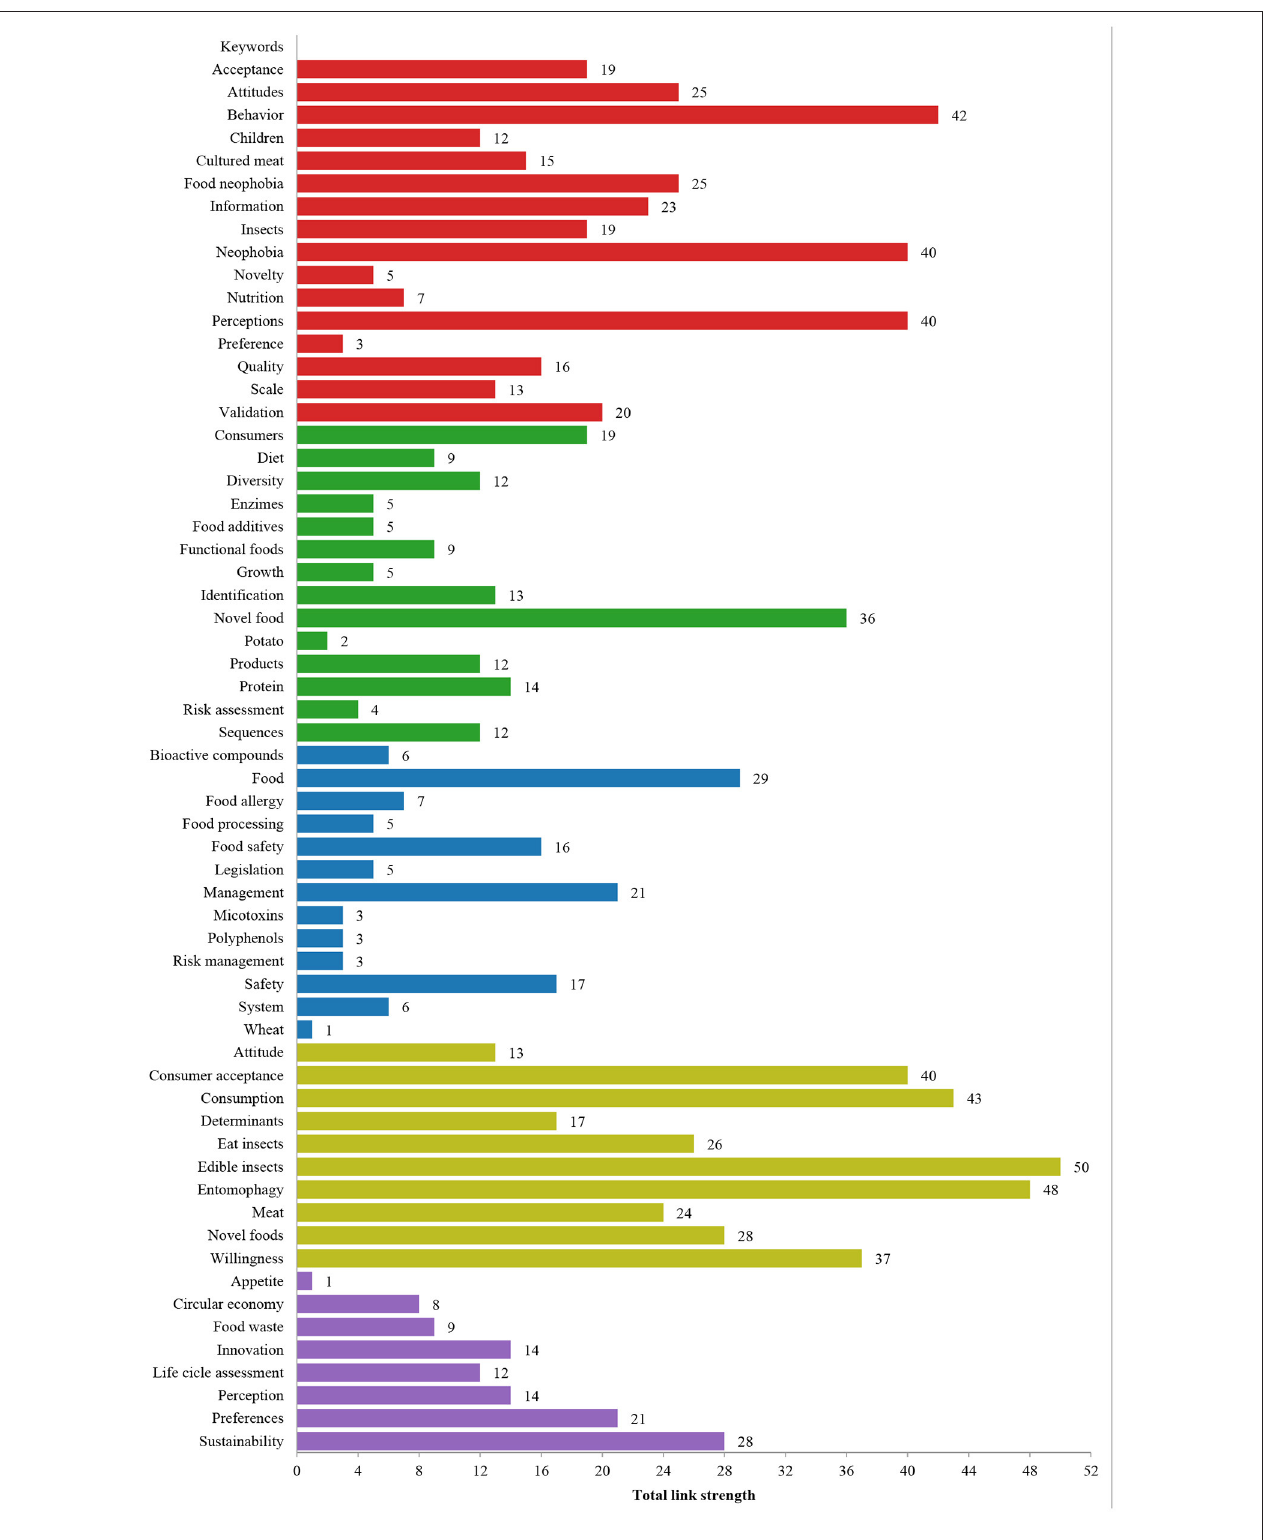
FIGURE 8 | Total link strength per cluster (Source: our elaboration).